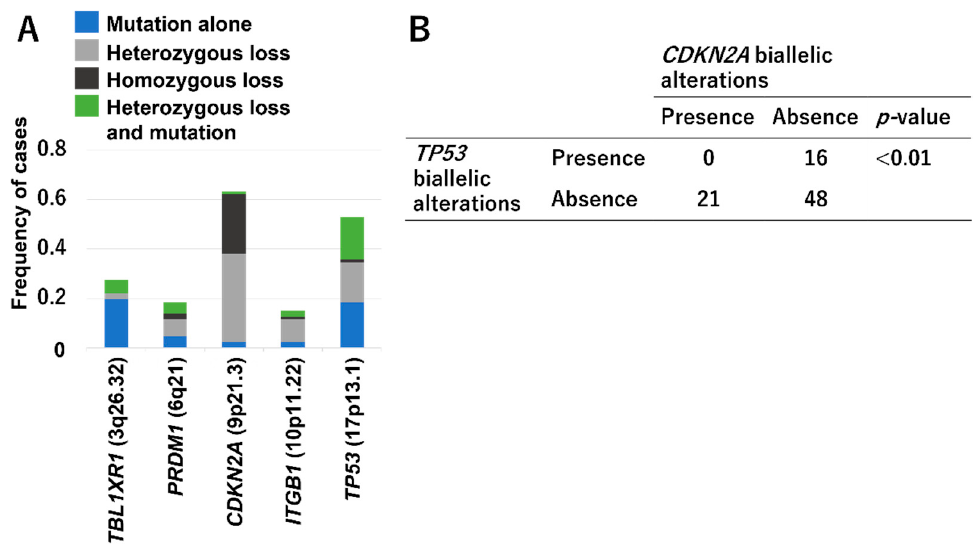
Figure 2. ( A ) Genes with significant biallelic alterations in ATLL based on our published data [17]. ( B ) Mutually exclusive nature of biallelic inactivation of TP 53 and CDKN 2 A . The p -value was calculated with two-sided Fisher’s exact test.